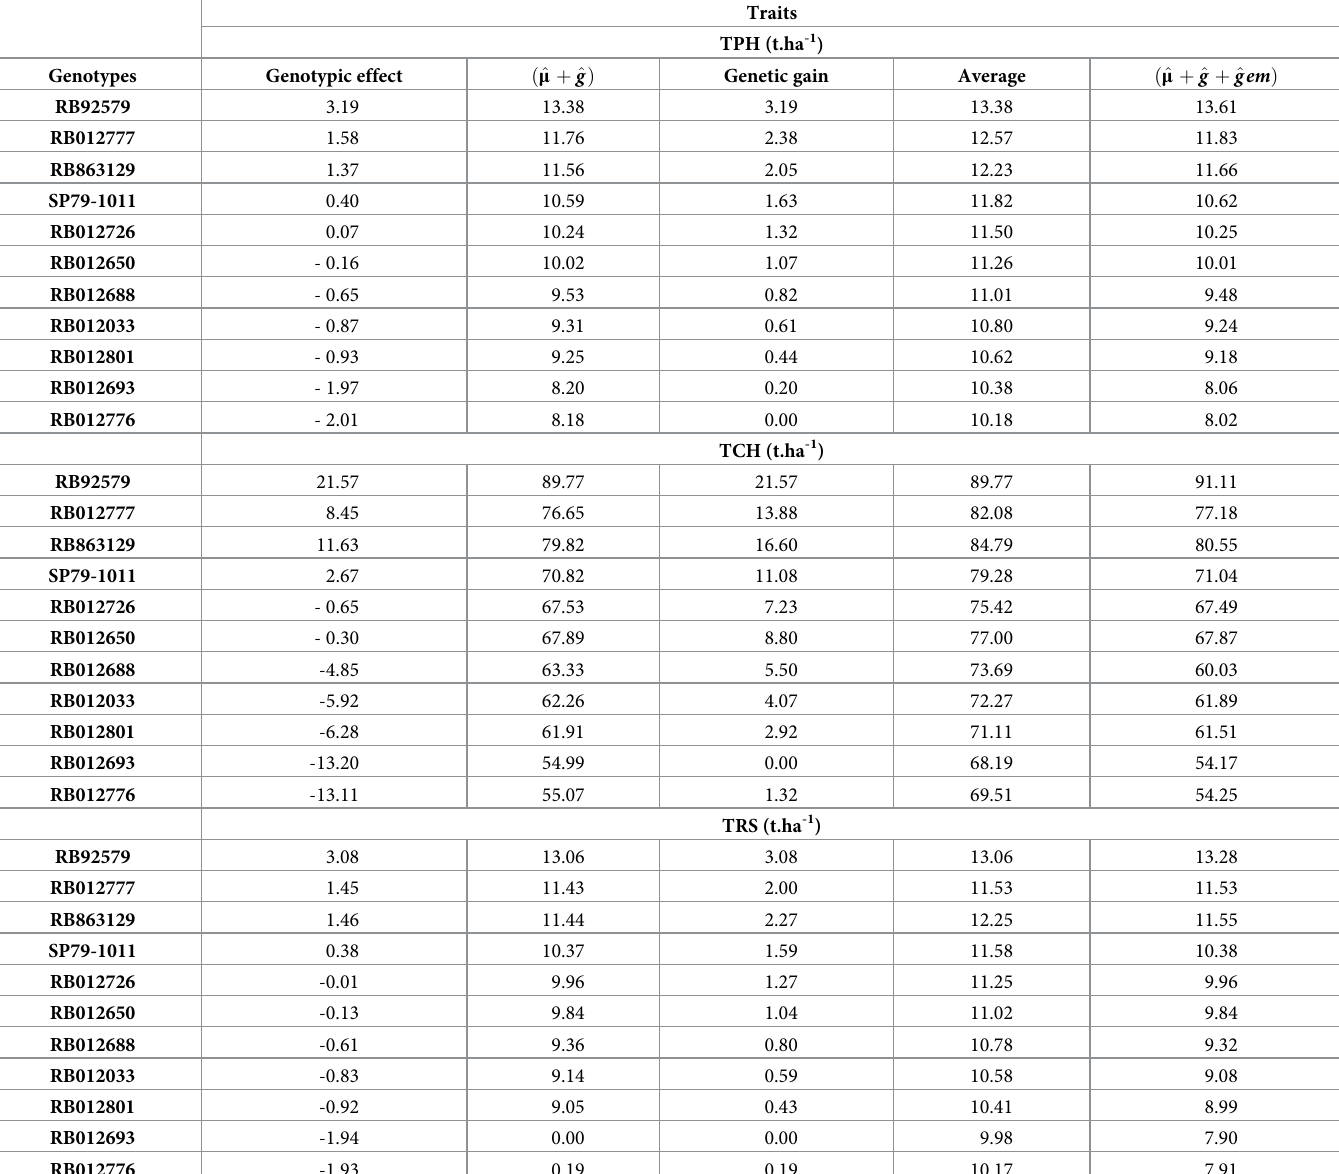
Table 6. Estimates of components of predicted averages and genotypic values (individual best unbiased linear predictor) of TCH(t.ha -1 ), TPH(t.ha -1 ), and TRS(t. ha -1 ) of sugarcane genotypes evaluated over two consecutive years during the final phases of trials conducted in sugarcane microregions in the State of